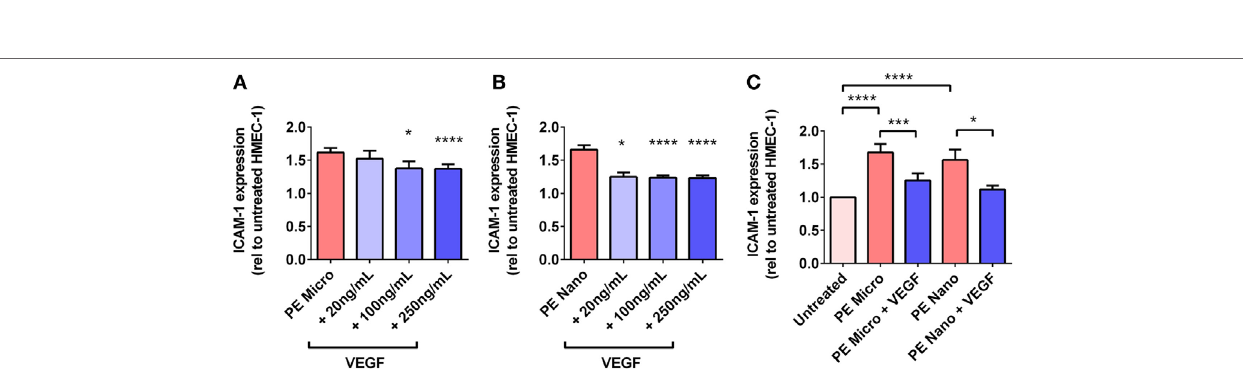
FigUre 5 | Levels of intercellular adhesion molecule 1 (ICAM-1) expression by human microvascular endothelial cell line (HMEC-1) cells after co-culture with preeclamptic (PE) micro- and nano-vesicles with and without vascular endothelial growth factor (VEGF) and Flt-1 neutralizing antibody. Micro- (a) and nano- (B) vesicles derived from PE placentae ( n = 7) were added to HMEC-1 cells in the presence or absence of recombinant VEGF (100 ng/mL) or Flt-1 neutralizing antibody (10 µg/mL, Flt Ab) or both, in quadruplicate. Human microvascular endothelial cells were also cultured with sFlt-1 (200 pg/mL) as a positive control. After 24 hours, surface ICAM-1 expression was measured by cell-based ELISA. Data are presented relative to basal ICAM-1 expression by untreated HMEC-1 cells (mean ± SEM, ** p < 0.01, *** p < 0.001, **** p < 0.0001, paired t